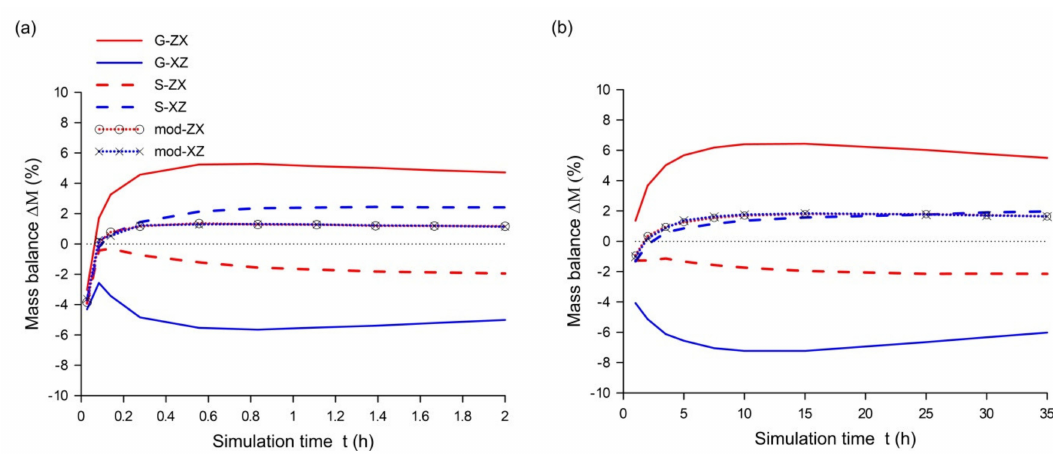
Figure 11. Mass balance error for di ff erent simulation times ( η = 0.5, N min = 3, N max = 7) for the Mualem–van Genuchten model: ( a ) sand and ( b ) loam.